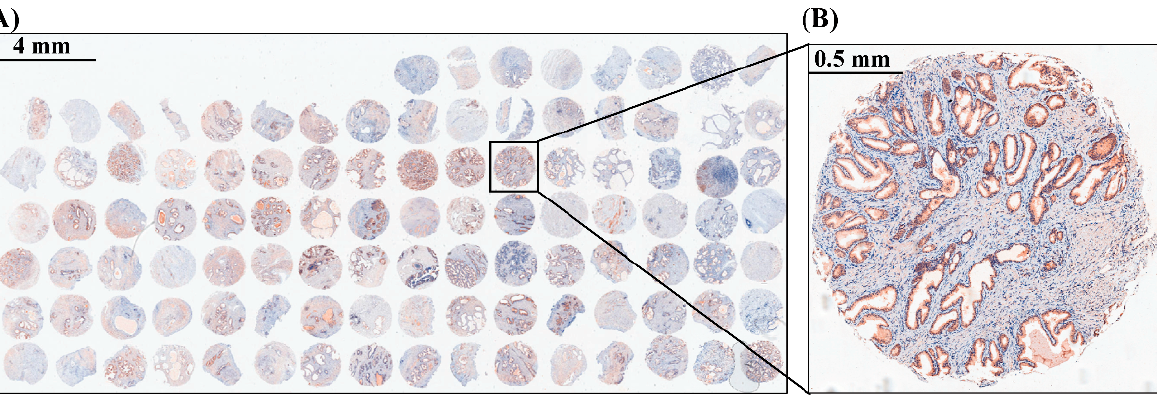
Figure 9. Immunohistochemical of CXCL13 on TMA of BPH. ( A ) A holistic view of CXCL13 stained TMA. The scale bar is 4 mm. ( B ) Representative graph of CXCL13 stained TMA. The scale bar is 0.5 mm. Table 2. The descriptive statistics of clinical parameters of BPH patients. Table 5. The descriptive statistics of clinical parameters of BPH patients.